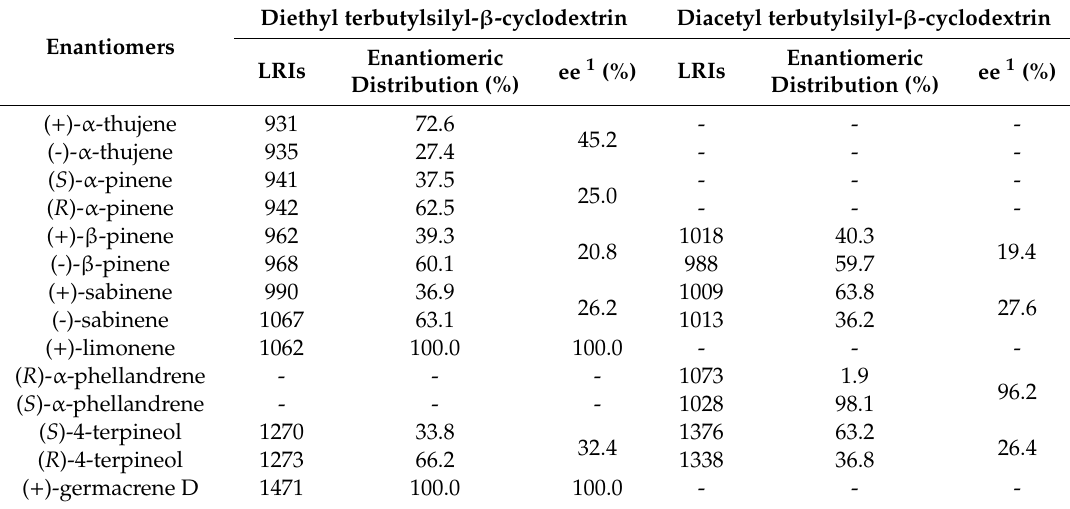
Table 3. Enantioselective GC analysis of M. myrsinoides EO.